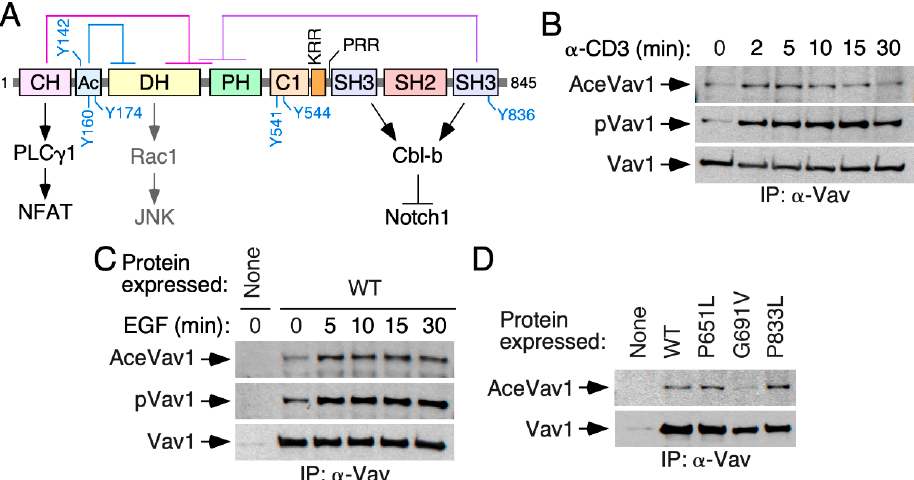
Figure 1. Vav1 lysine acetylation is stimulation- and SH2-dependent. ( A ) Schematic representation of the structure of Vav1. The intramolecular interactions that maintain the inactive, nonphosphorylated state of the protein are shown on top. The main regulatory phosphosites are shown in blue. The main downstream pathways are shown at the bottom. Abbreviations have been introduced in the main text. ( B ) Kinetics of Vav1 lysine acetylation (top panel) and tyrosine phosphorylation (middle panel) in T cell receptor (TCR)-stimulated Jurkat cells. The bottom panel shows the amount of endogenous Vav1 immunoprecipitated in each experimental time-point. Similar results were obtained in six independent experiments. Ace, acetylated; p, tyrosine-phosphorylated; IP, immunoprecipitation. ( C ) Kinetics of Vav1 lysine acetylation (top panel) and tyrosine phosphorylation (middle panel) in epidermal growth factor (EGF)-stimulated COS1 cells. The bottom panel shows the amount of ectopically expressed Vav1 immunoprecipitated in each experimental condition. Similar results were obtained in three independent experiments. ( D ) Levels of Lys acetylation (top panel) and Tyr phosphorylation (middle panel) of indicated Vav1 mutant proteins ectopically expressed in COS1 cells. The bottom panel shows the amount of immunoprecipitated Vav1 obtained in each case ( n = 3).